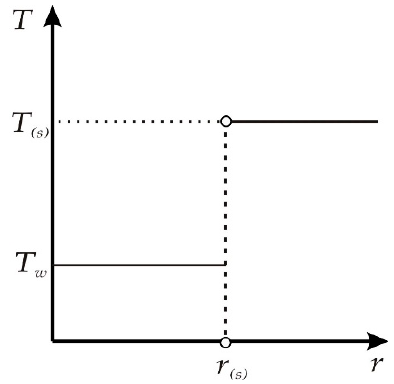
Figure 2. The change in temperature on coordinate r .